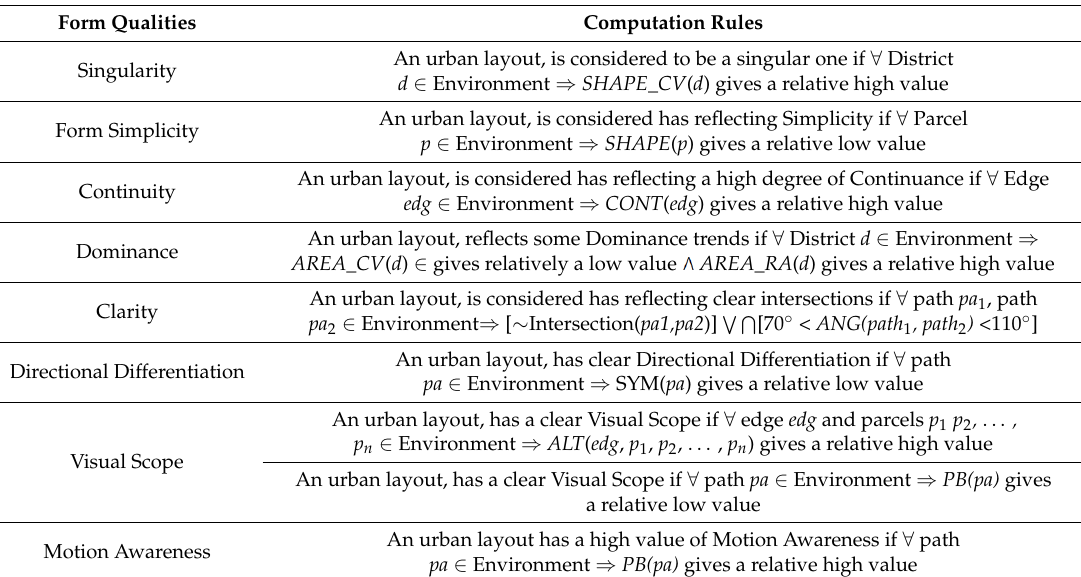
Table 6. Qualities forms and computational